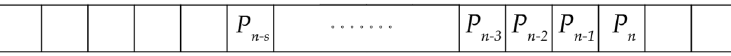
Figure 8. Assuming the pixels of the image line up in a row.